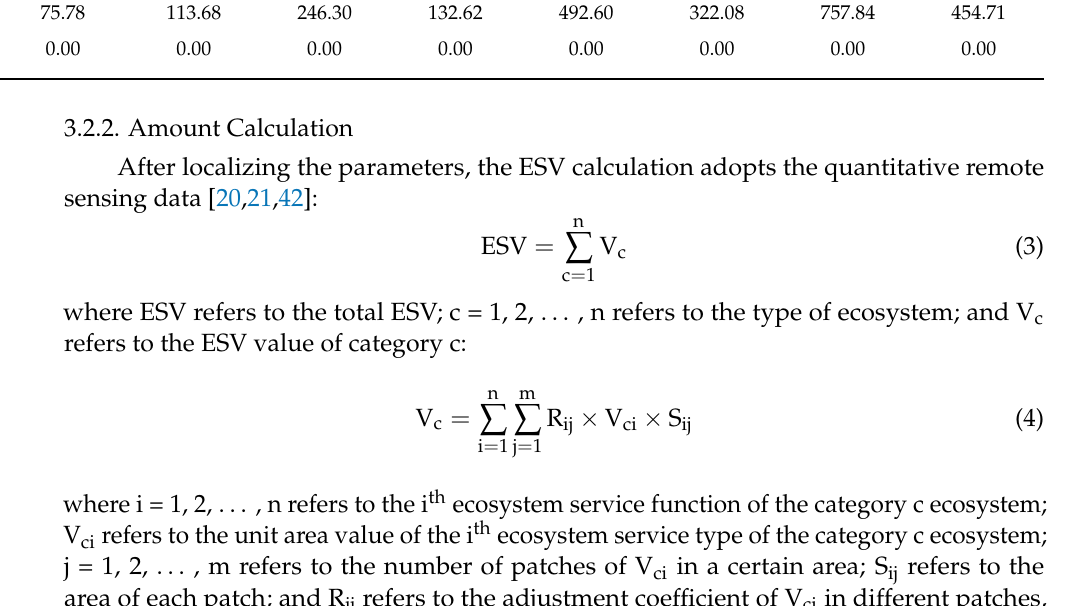
Table 3. ESVs of different ecosystems per unit area in the Central Plains Urban Agglomeration (RMB · hm − 2 .a − 1 ). Raw Food Ecosystems Material Production